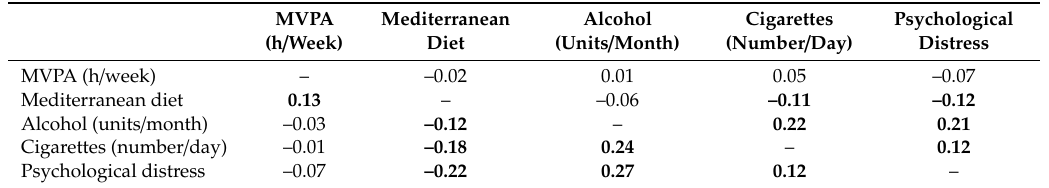
Table 2. Correlations between the predictors of enlistment for recruits rejected for (above the diagonal) and enlisted into (below the diagonal) military